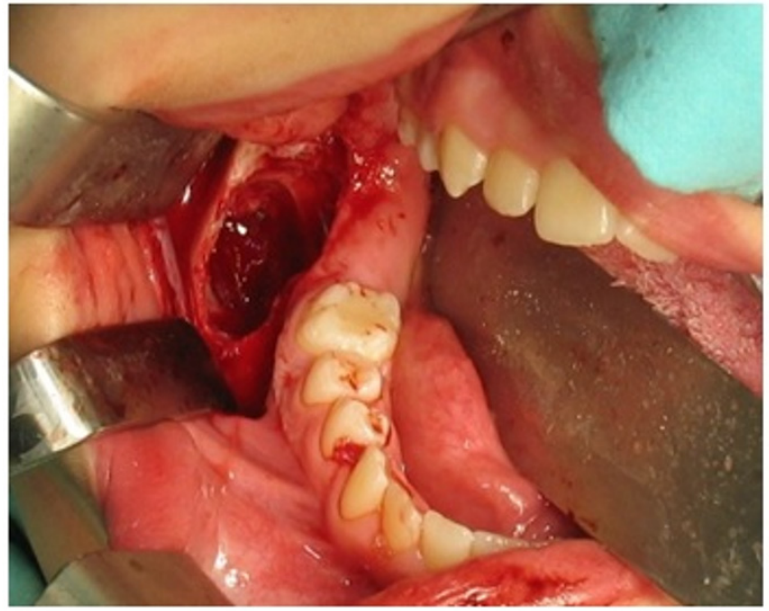
Figure 5. Intraoperative photo of the bony defect after removal of the lesion and impacted tooth 47. Courtesy of Dr. W. Pawlak.